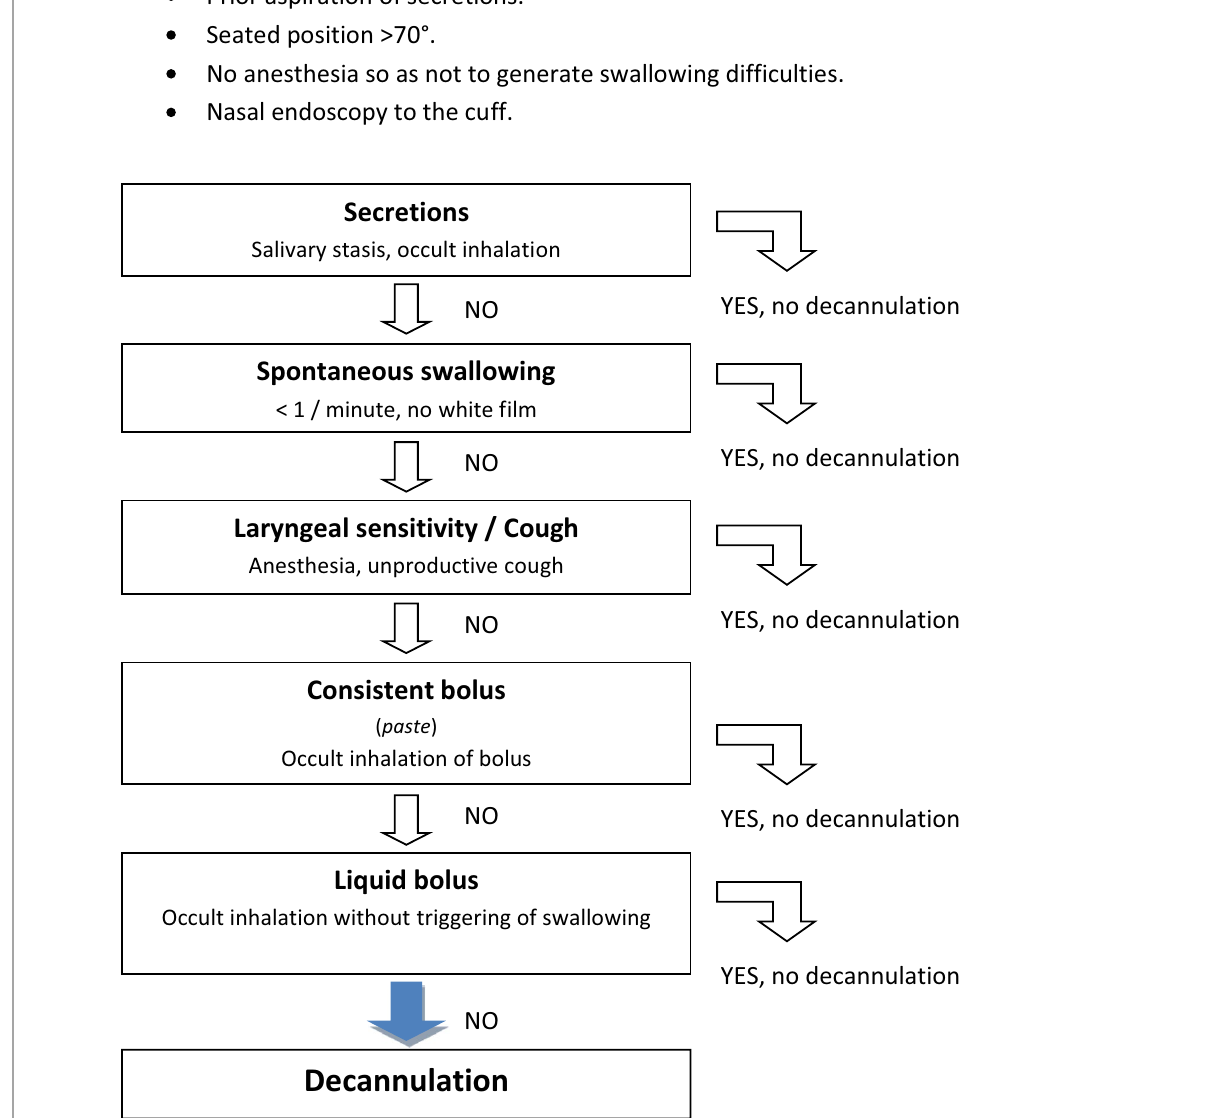
Fig. 4 Proposed endoscopic protocol associated with guideline 5.1 (Expert opinion): (according to Warnecke et al . Crit Care Med 2013 (106)